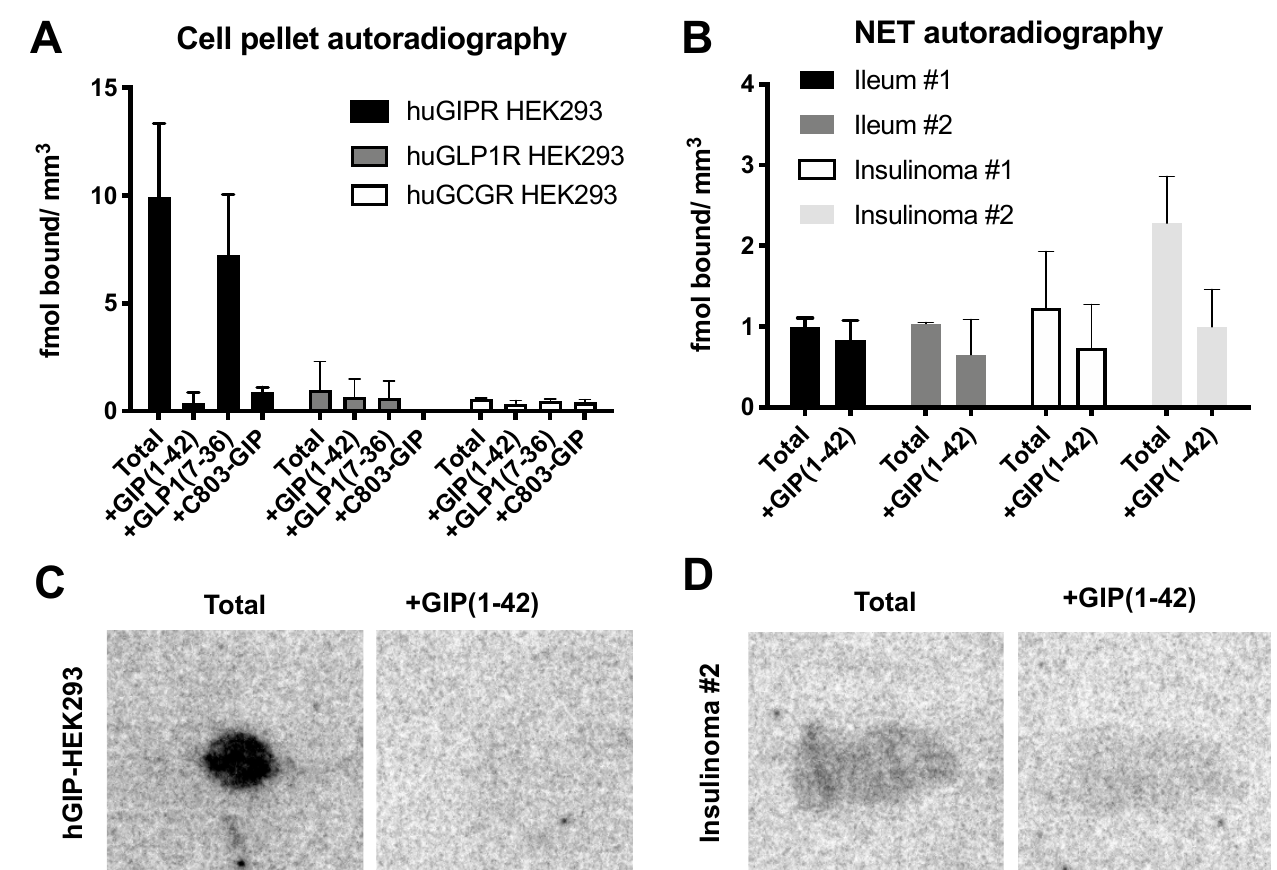
Figure 4. ( A ) Verification of the binding specificity of [ 68 Ga]Ga-C803-GIP in huGIPR-HEK293, huGLP1R-HEK293, and hGCG-HEK293 cell pellet sections. The uptake was challenged using 10 µM GIP(1-42), GLP1(7-36), or C803-GIP in all cell lines. ( B ) Binding of [ 68 Ga]Ga-C803-GIP to frozen sections of human biopsies of NETs from ileum and insulinomas of the pancreas in the presence and absence of 5 µ M GIP(1-42). ( C , D ) Representative autoradiograms of [ 68 Ga]Ga-C803-GIP binding to frozen sections of hGIP-HEK293 cell pellets and insulinoma #2. 2.5. In Vivo Organ Distribution of [ 68 Ga]Ga-C803-GIP in Rat The organ distribution kinetics of [ 68 Ga]Ga-C803-GIP was studied in male Sprague Dawley rats ( n = 16). Two animals were sacrificed at each of the eight time points as depicted in Figure 5A. Most tissues exhibited a rapid clearance of radioactive uptake except for the kidney, which is an excretory organ. The liver-to-blood ratio increased with time indicating faster blood clearance compared to the washout from the organ (Figure 5B). Four rats received a co-injection of 1 mg/kg of C803-GIP precursor in the competition experiment. The in vivo competition showed no significant displacement in the liver or pancreas or in any other organ in the presence of an excess of non-labeled precursor C803-GIP at 20 min post injection (Figure